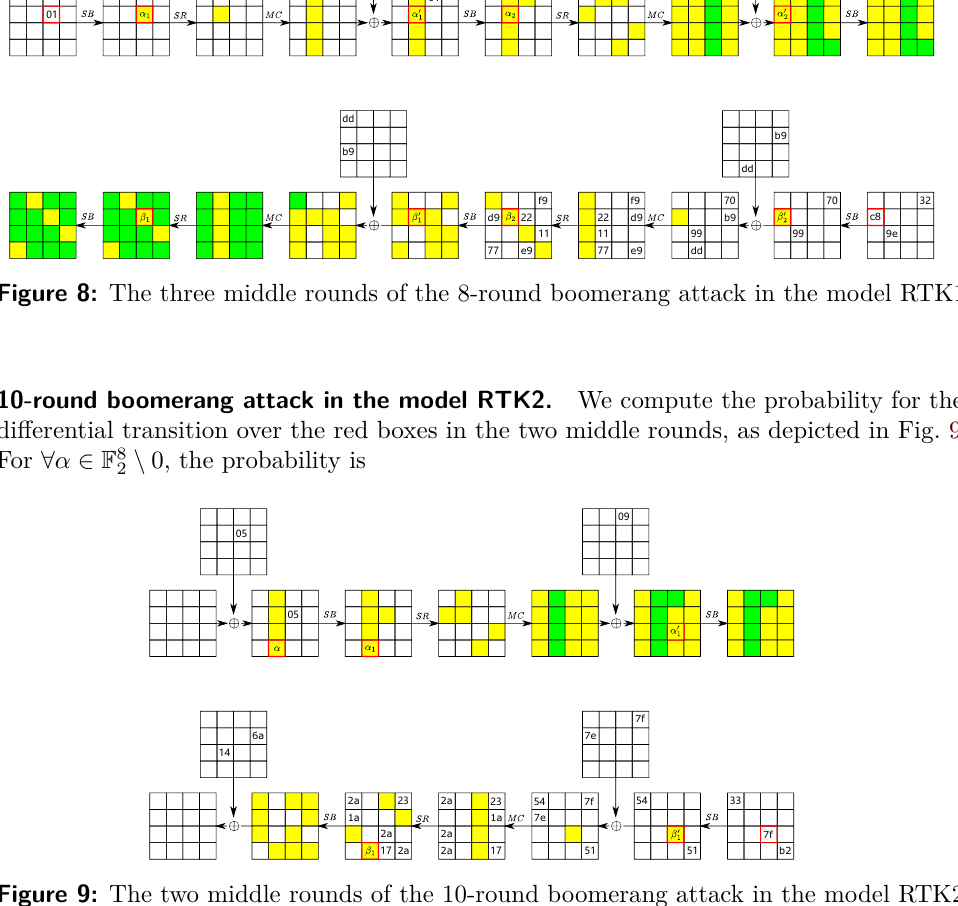
X P = 1 · UBCT ( α, α 1 , β 1 ) · LBCT ( α ′ 2 2 · 8 α 1 ,β ′ 1